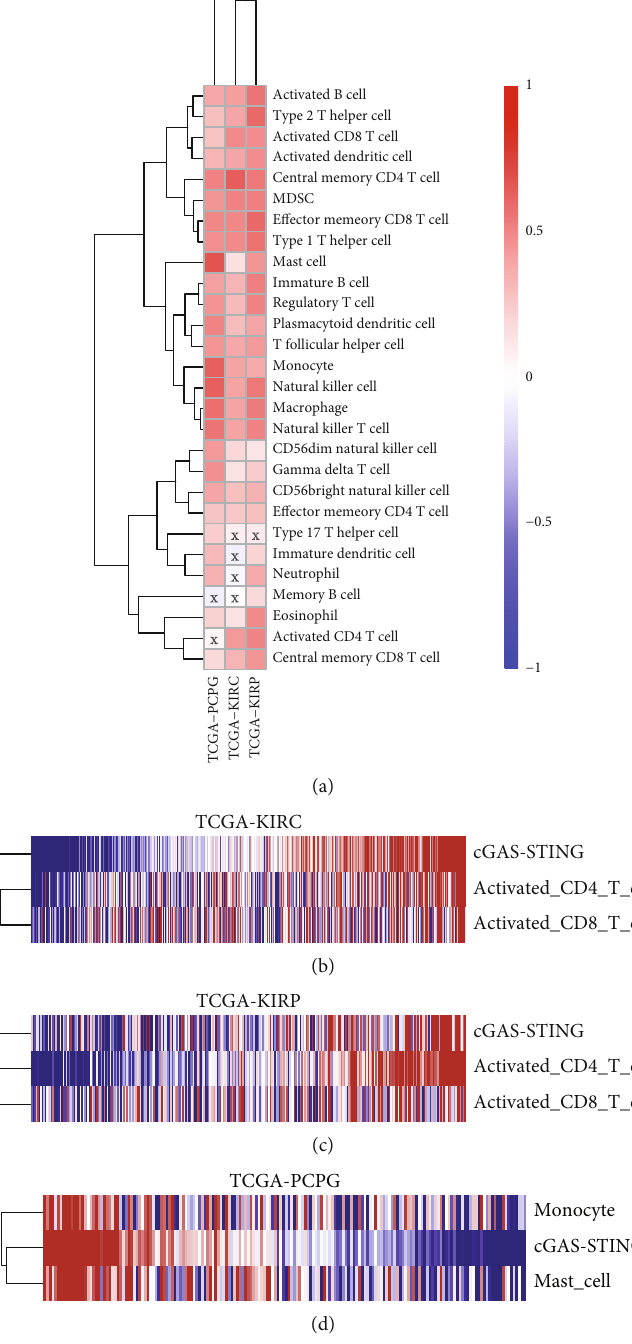
Figure 5: Correlation between the cGAS-STING sensor and TIICs in KIRC, KIRP, and PCPG. (a) Heatmap showed the correlation e ffi ciency between cGAS-STING sensor and di ff erent immune cells in KIRC, KIRP, and PCPG; in fi ltrating immune cells in di ff erent groups were calculated by CIBERSORT. (b) Heatmap showed the activity score of cGAS-STING sensor on activated CD4 T cells and activated CD8 T cells in KIRC. (c) Heatmap showed the activity score of the cGAS-STING sensor on activated CD4 T cells and activated CD8 T cells in KIRP. (d) Heatmap showed the activity score of the cGAS-STING sensor on monocyte and mast cells in